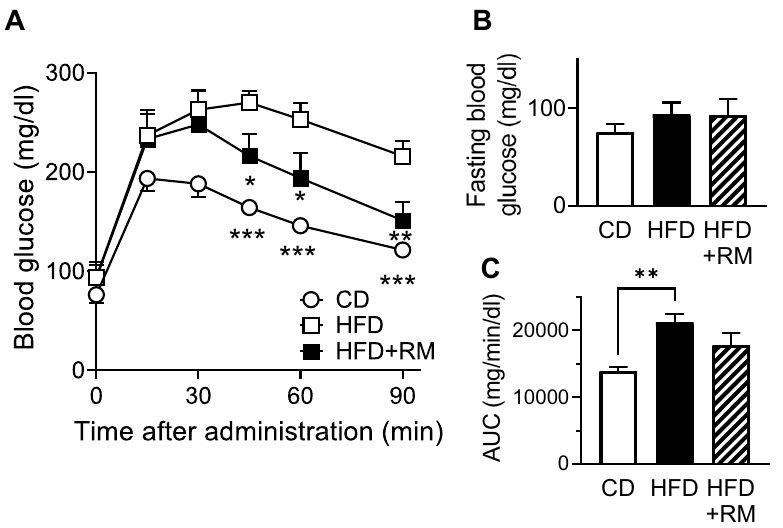
Figure 6. Rice-memolin reduces blood glucose. ( A – C ) The OGTT was performed, n = 6–7. * P < 0.05, ** P < 0.01, *** P < 0.001 vs. HFD group. RM: Rice-memolin.